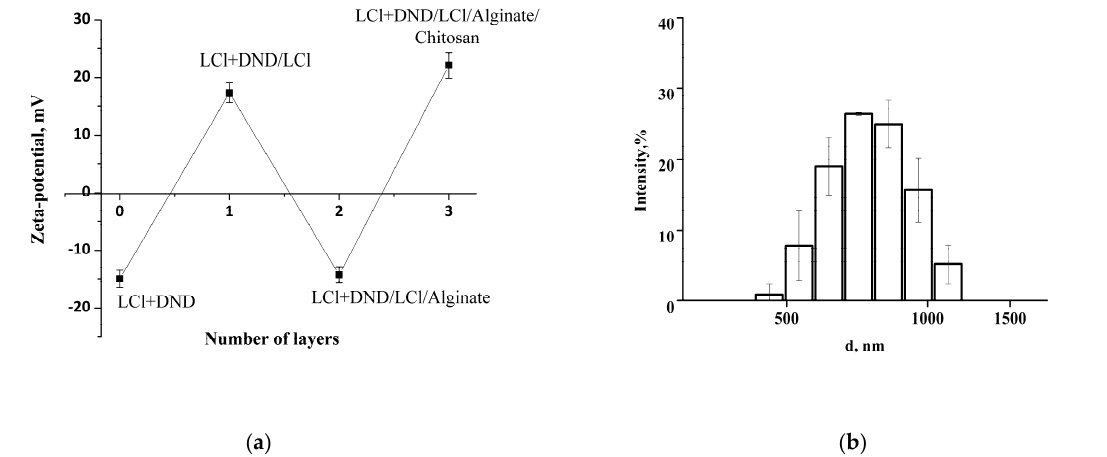
Figure 8. ( a ) The zeta-potential change as a result of multilayer shell formation (pH 4); ( b ) the size distribution of the (LCl + DND)/LCl/alginate/chitosan capsules.